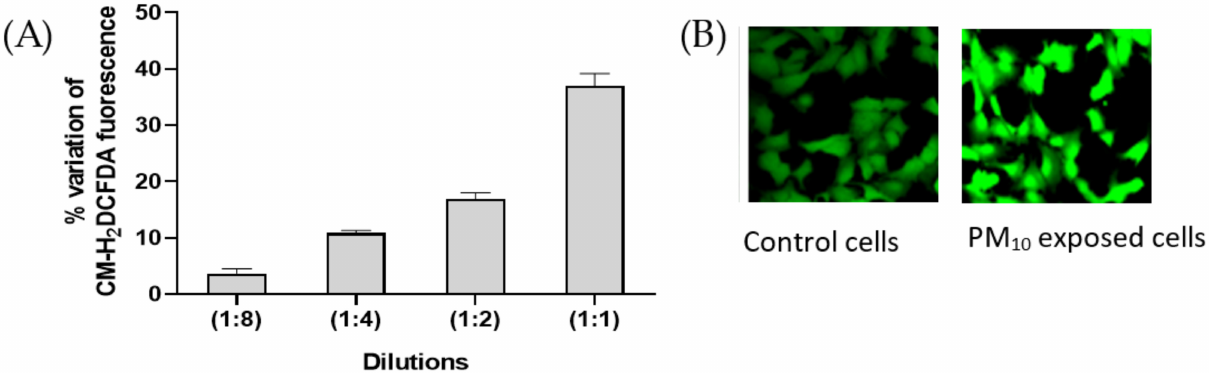
Figure 3. ( A ) Cell-mediated oxidant generating capacity of PM 10 (expressed as percentage variation of fluorescence intensity vs. negative control) in A549 cells exposed for 24 h to increasing dilutions of the aqueous extract obtained from PM 10 collected on 20/3/2019; ( B ) Representative confocal images of control and PM 10 exposed (24 h) A549 cells charged with the probe CM-H 2 DCFDA.